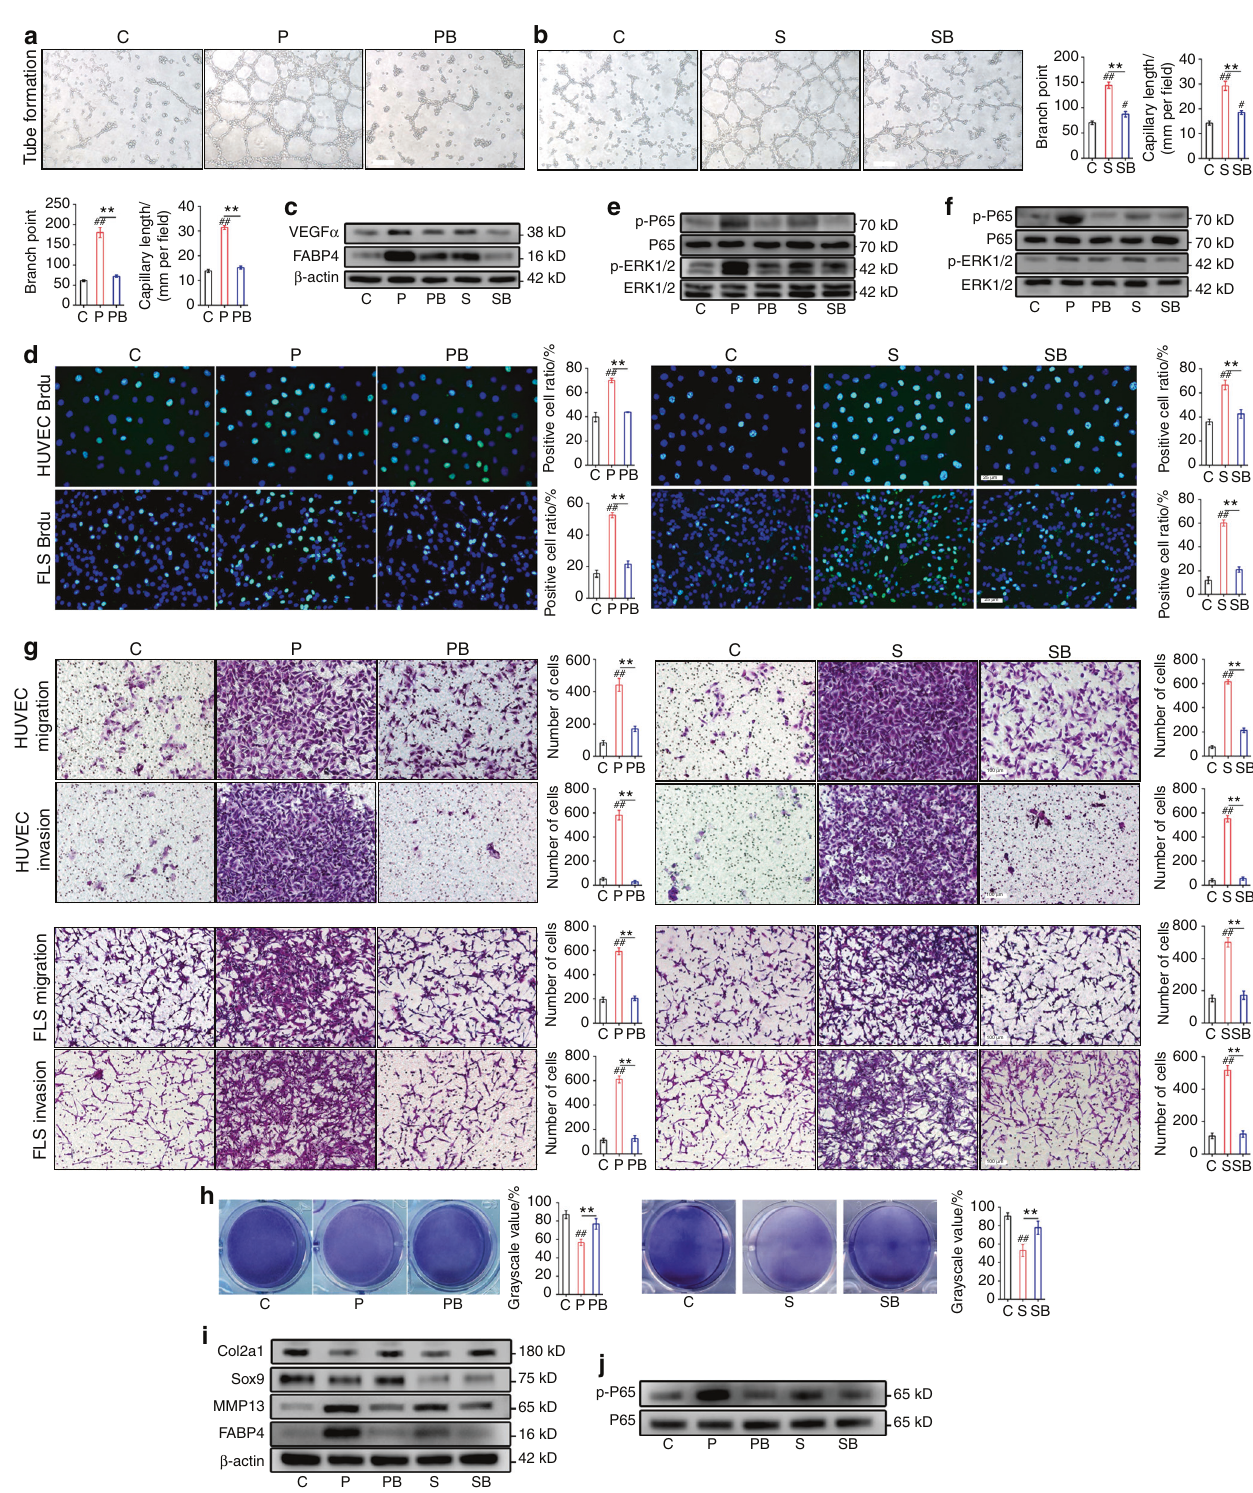
Fig. 2 The effect of FABP4 and M1-polarized macrophage supernatant on HUVECs, FLSs, and chondrocytes in vitro. a , b Tube formation assay and quanti fi cation of HUVECs cultured with vehicle (C), rhFABP4 (P), rhFABP4 + BMS309403 (PB), M1-polarized macrophage supernatant (S), or M1- polarized macrophage supernatant + BMS309403 (SB) ( n = 3 per group). Scale bar: 100 µm. c Immunoblot analysis of FABP4 and VEGF α in HUVECs cultured with C, P, PB, S, or SB for 24h. d , g Representative images and quanti fi cation of BrdU (green) immuno fl uorescence ( d ) and Transwell assays ( g ) in HUVECs and FLSs treated with C, P, PB, S, or SB for 24h ( n = 3 per group). Scale bar: 25µm, 100µm. e , f Immunoblot analysis of ERK1/2, p- ERK1/2, P65, and p-P65 in HUVECs ( e ) and FLSs ( f ) treated with C, P, PB, S, or SB for 1 h. h Toluidine blue staining of ATDC5 cells treated with C, P, PB, S, or SB for 24 h ( n = 3 per group). i Immunoblot analysis of FABP4, MMP13, Sox9, and Col2a1 in primary chondrocytes treated with C, P, PB, S, or SB for 24h. j Immunoblot analysis of P65 and p-P65 in primary chondrocytes treated with C, P, PB, S, or SB for 1 h. One-way ANOVA and Tukey ’ s multiple comparison test. * P < 0.05, ** P < 0.01; # P < 0.05, ## P < 0.01 compared to the control. The data are shown as the mean ±